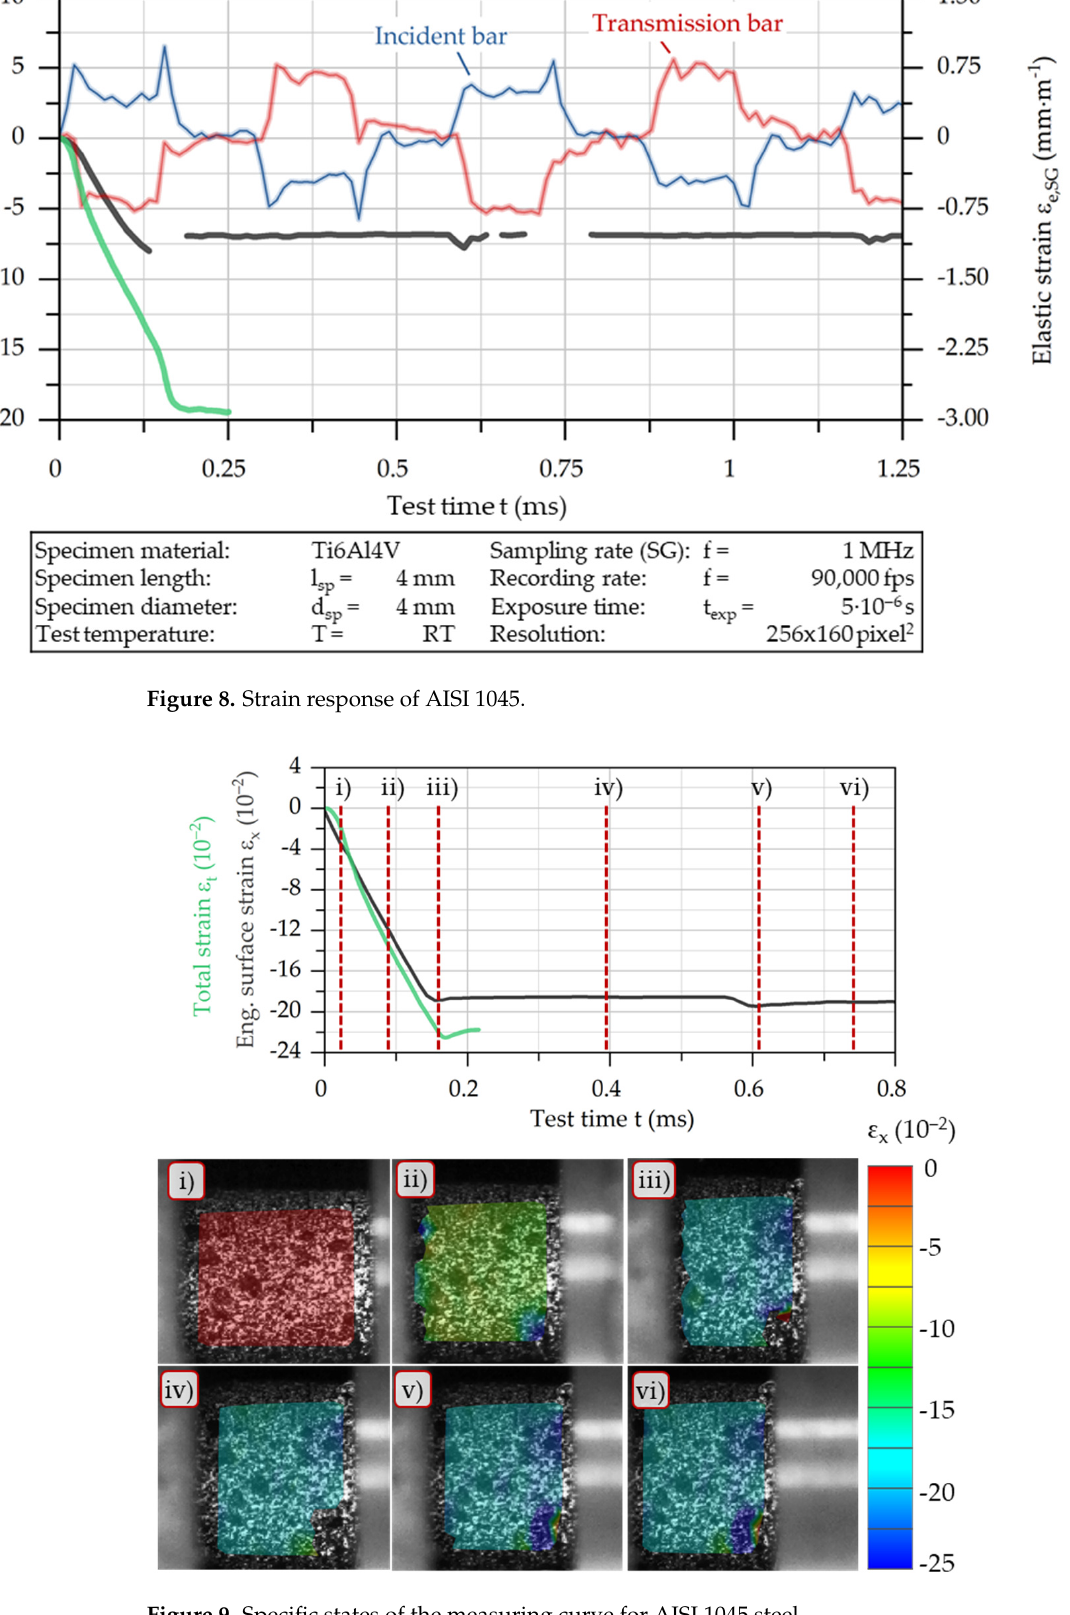
Figure 9. Specific states of the measuring curve for AISI 1045 steel.